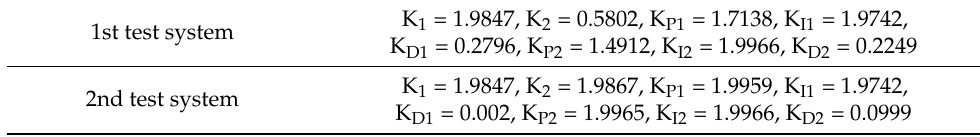
Table 6. Optimized parameters for two test systems.